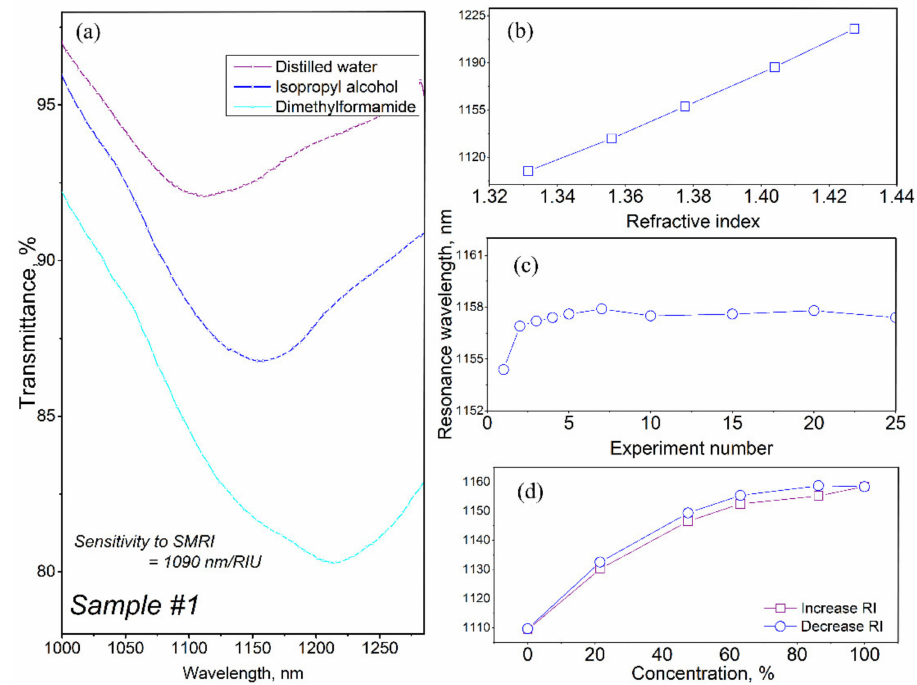
Figure 6. Characteristics of sample #1: ( a )—transmission spectrum depending on the medium covering the sensor, ( b )—dependence of the spectral position of the LMR on the refractive index of the environment, ( c )—resonance position during repeated filling with isopropyl alcohol, ( d )—shift of the resonance position in aqueous solutions of isopropyl